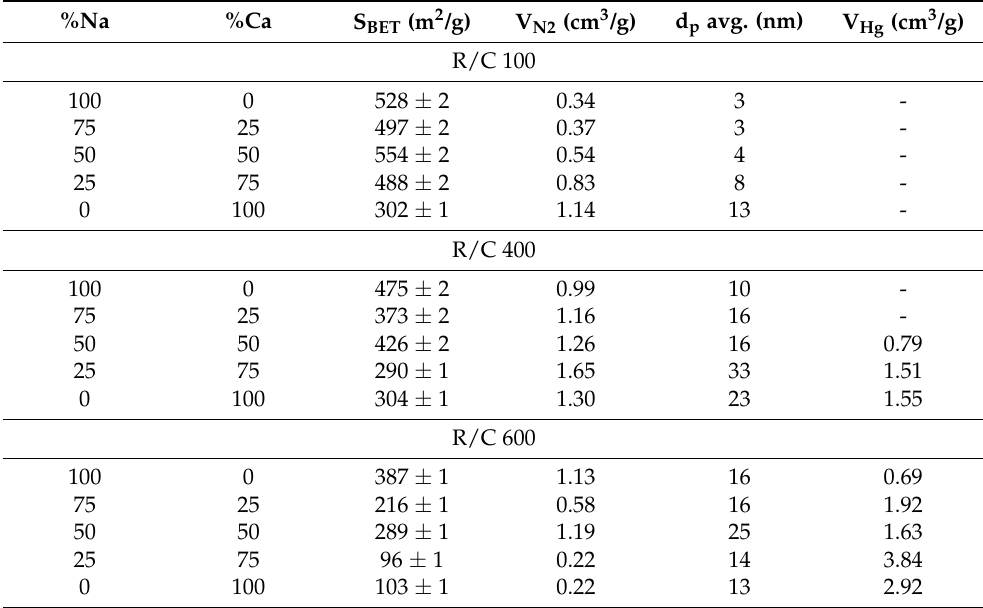
Table 3. The textural properties obtained for the resorcinol–formaldehyde xerogels produced using a 30% solids